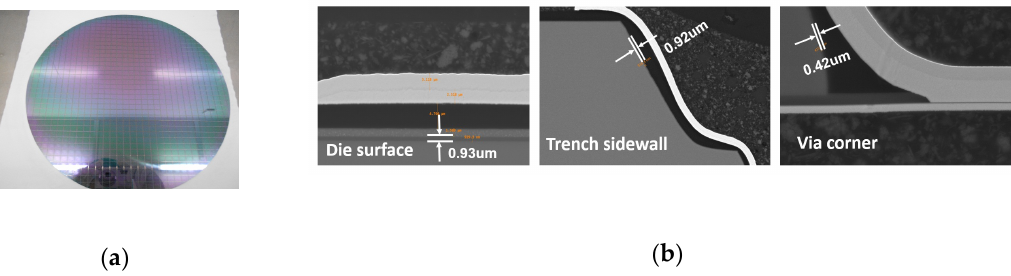
Figure 14. ( a ) The outlook of the wafer after PECVD process. ( b ) The SEM cross-section images of die surface, trench sidewall and via corner.